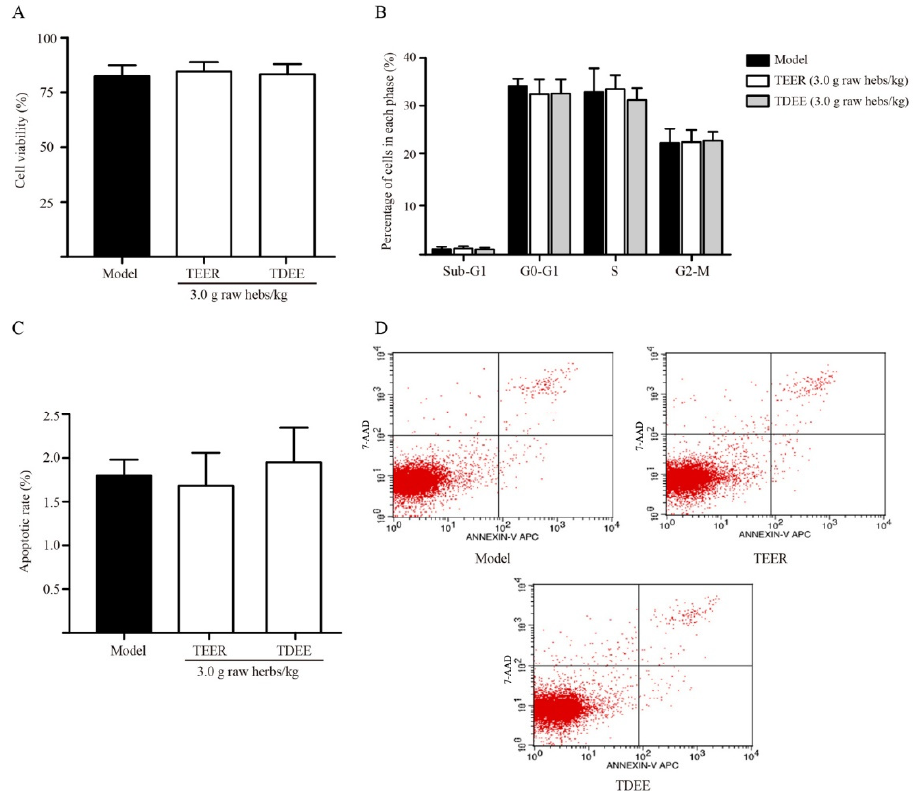
Figure 2. Effects of extracts from the root of Euphorbia ebracteolata Hayata (EER) on cell viability, cell cycle and apoptosis in H22 tumor cell-bearing mice. ( A ) Cell viability rate. ( B ) Percentage of cells in each cycle phase. ( C , D ) Cell apoptosis with Annexin V-FITC/PI dual-staining (flow cytometry). Model: H22 tumor cell-bearing mice treated with blank solvent. TEER: total extract of EER; TDEE: total diterpenoids from EER. The data are represented as the mean ± SD, n = 6. Significant differences compared to model group were analysed by one-way ANOVA with Dunnett test, but there were no significant differences.